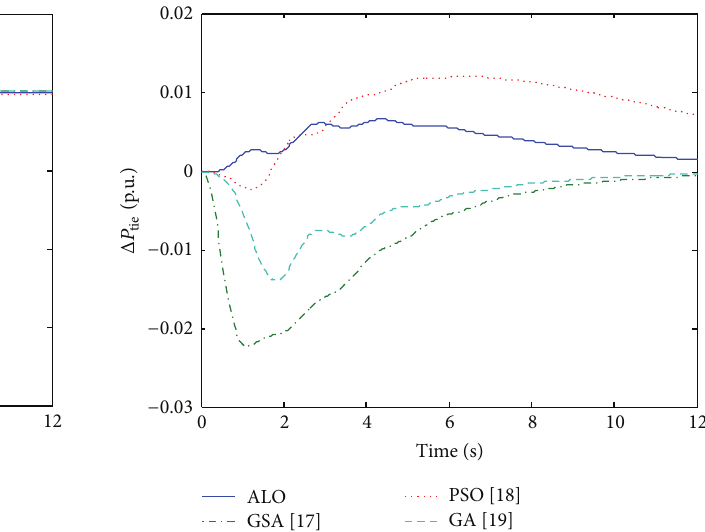
Figure 4: Change in frequency of area 1 by 10% load increase in area 1.